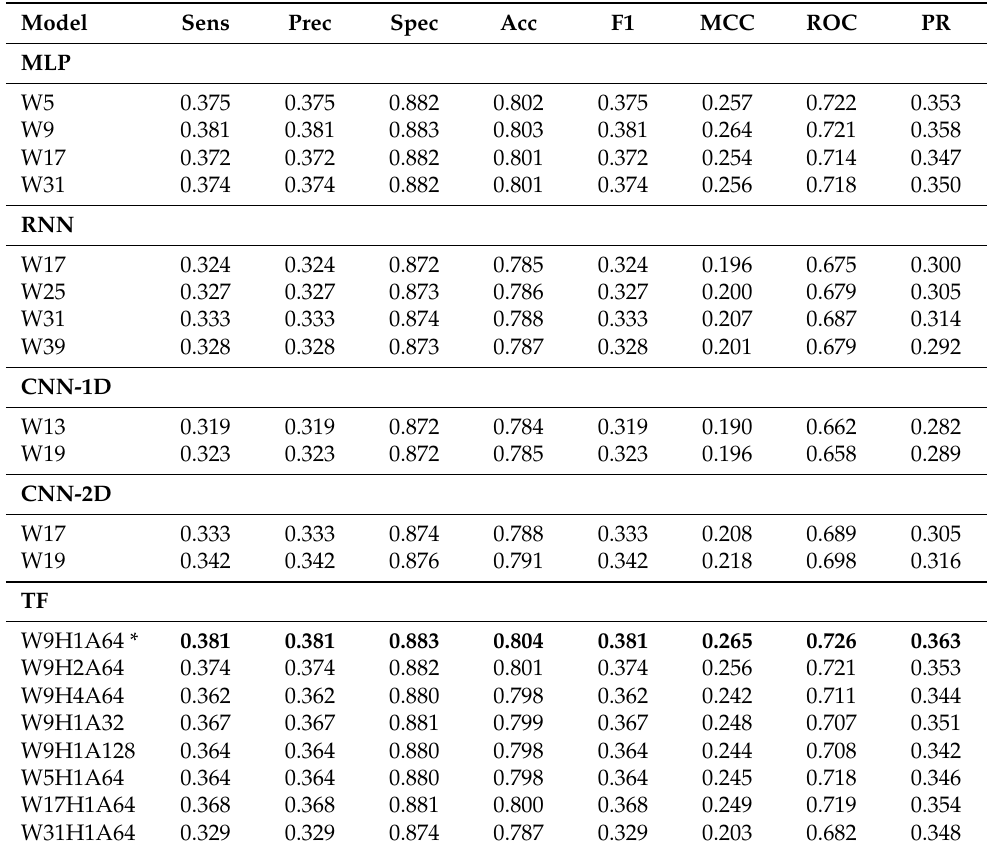
Table 5. Model comparison: W w , H h , and A a mean window size w , h attention heads, and multiple alignment size a , respectively. The best results are shown in boldface. * W9H1A64 is the final PITHIA